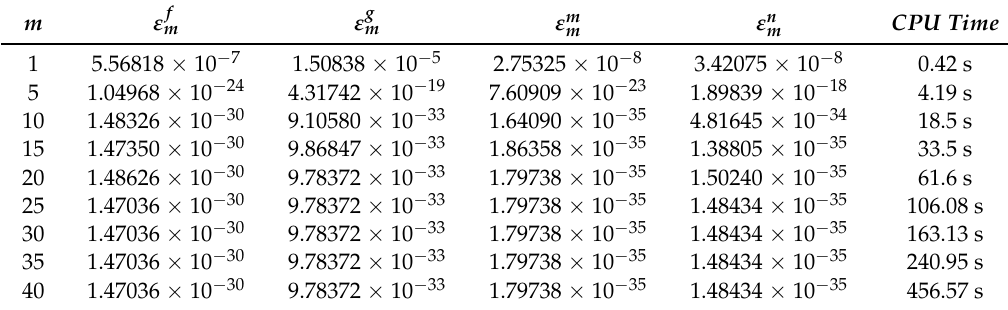
Table 1. Estimating the total residual error with fixed values of S z = − 0.1, M x = 0.1, M y = 0.3, R m = 0.01, and S = 1, for different orders of